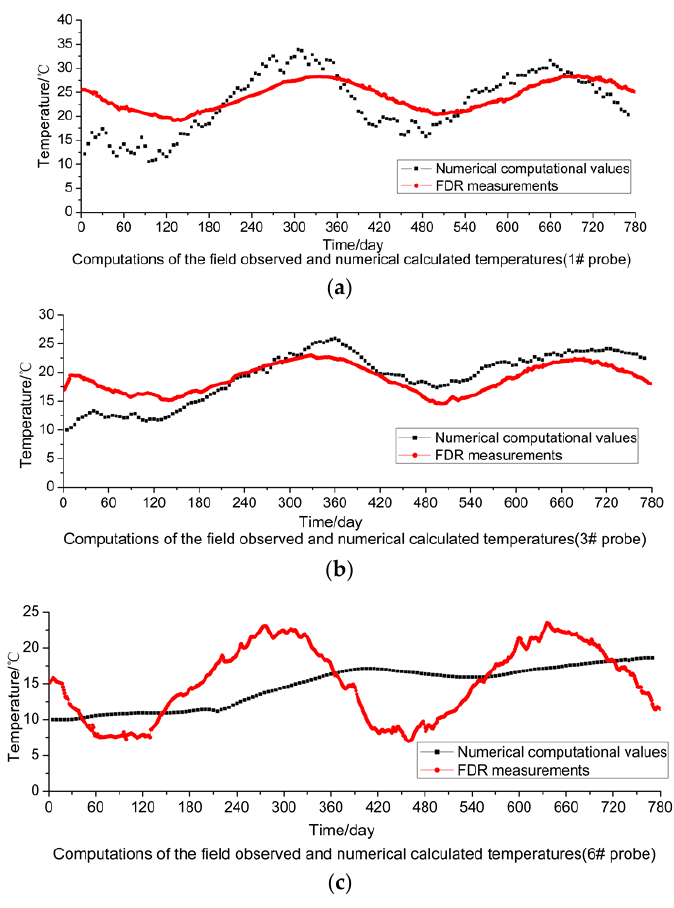
Figure 11. Comparison of measured and calculated temperatures: ( a ) #1 probe; ( b ) #3 probe; ( c ) #6 probe.